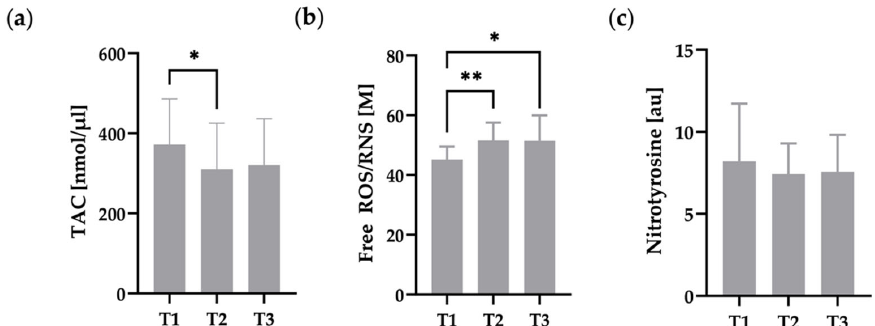
Figure 4. Oxidative status of RBC, indicating ( a ) significantly reduced total antioxidant capacity (TAC) and ( b ) significantly increased free ROS/RNS due to hypoxia. ( c ) Nitrotyrosine concentration